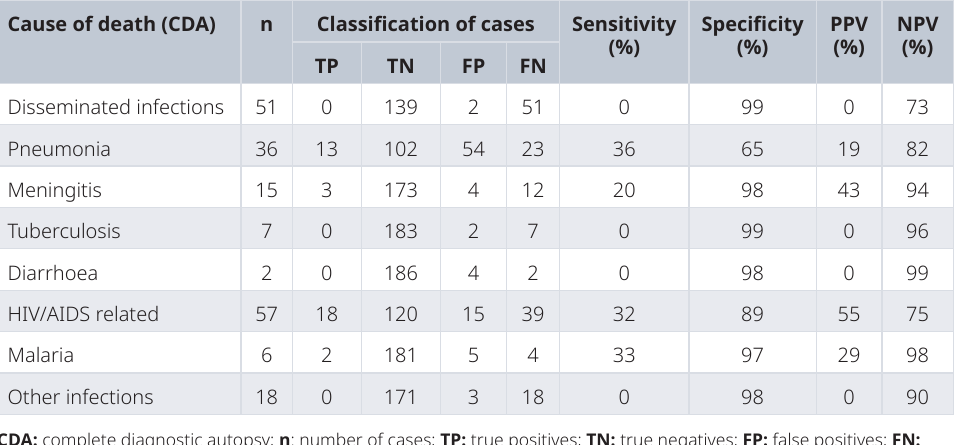
CDA: complete diagnostic autopsy; n : number of cases; TP: true positives; TN: true negatives; FP: false positives; FN: false negatives; PPV: positive predictive value; NPV: negative predictive value; N/A: not applicable Disseminated infections: bacterial sepsis of newborn (n=21), puerperal sepsis (n=6), streptococcal sepsis (n=5) and other sepsis (n=19) HIV/AIDS related infections: candidiasis (n=1), congenital viral diseases (n=1), cryptococcosis (n=11), cytomegaloviral disease (n=7), herpes simplex infection (n=1), miliary tuberculosis (n=20), salmonella infections (n=1), pneumocystosis (n=5), pulmonary tuberculosis (n=2), toxoplasmosis (n=7) and tuberculous meningitis (n=1) Other infections: acute pericarditis (n=2), pyelonephritis (n=2), congenital viral diseases (n=2), chorioamnionitis (n=2), GBS infection (n=2), tetanus (n=1), peritonitis (n=3), rabies (n=3) and zygomycosis